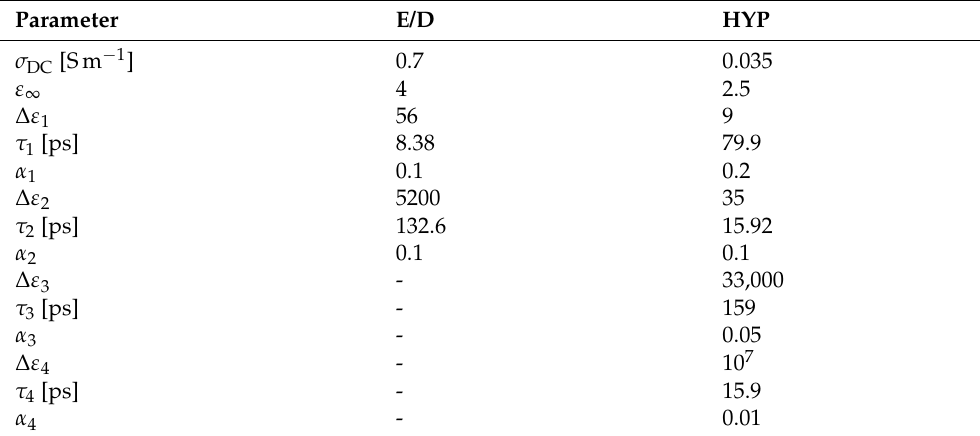
Table 2. Cole–Cole parameters for epidermis/dermis (E/D) and the hypodermis (HYP) layer in the skin model. The values refer to blood for E/D and infiltrated fat for HYP from [7]. Parameter E/D HYP σ DC [Sm − 1 ] 0.7 0.035 ε ∞